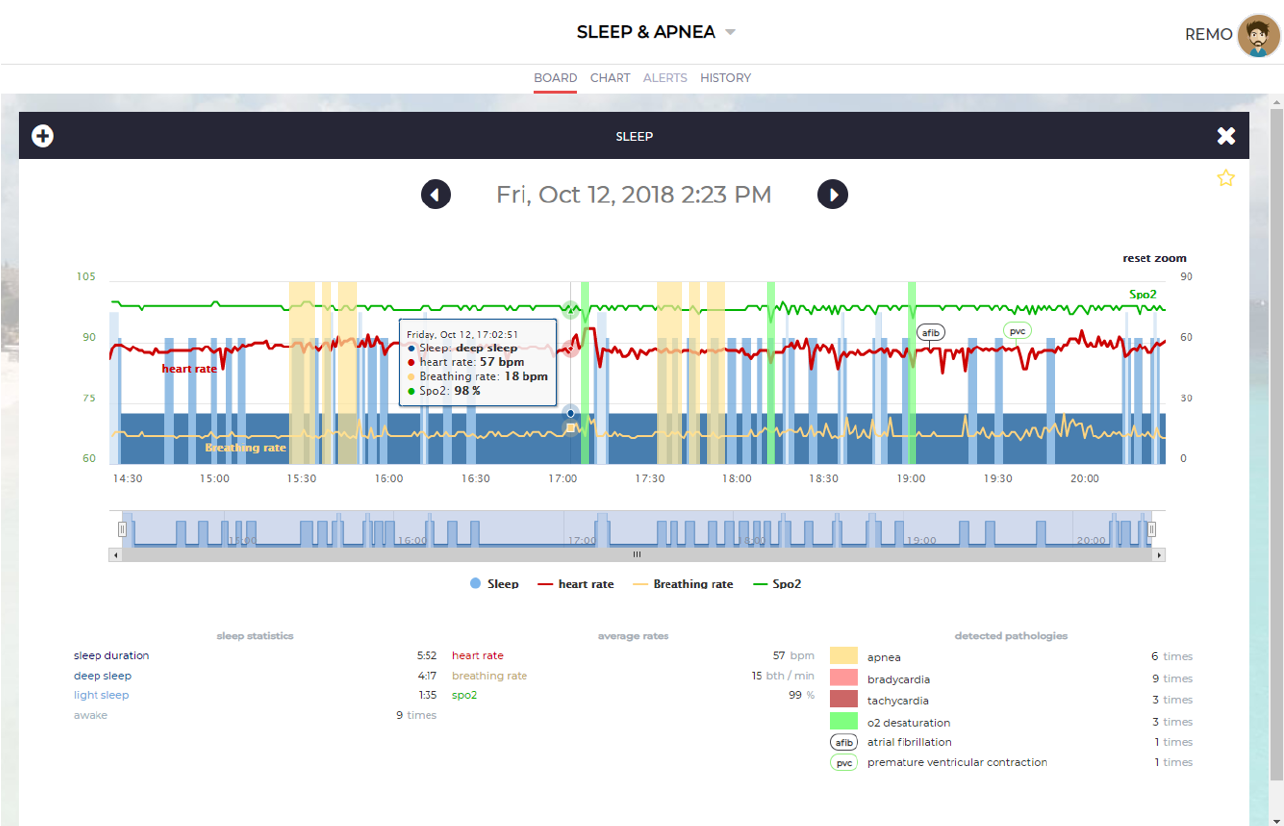
Figure 6. The user interface of the UpNEA web